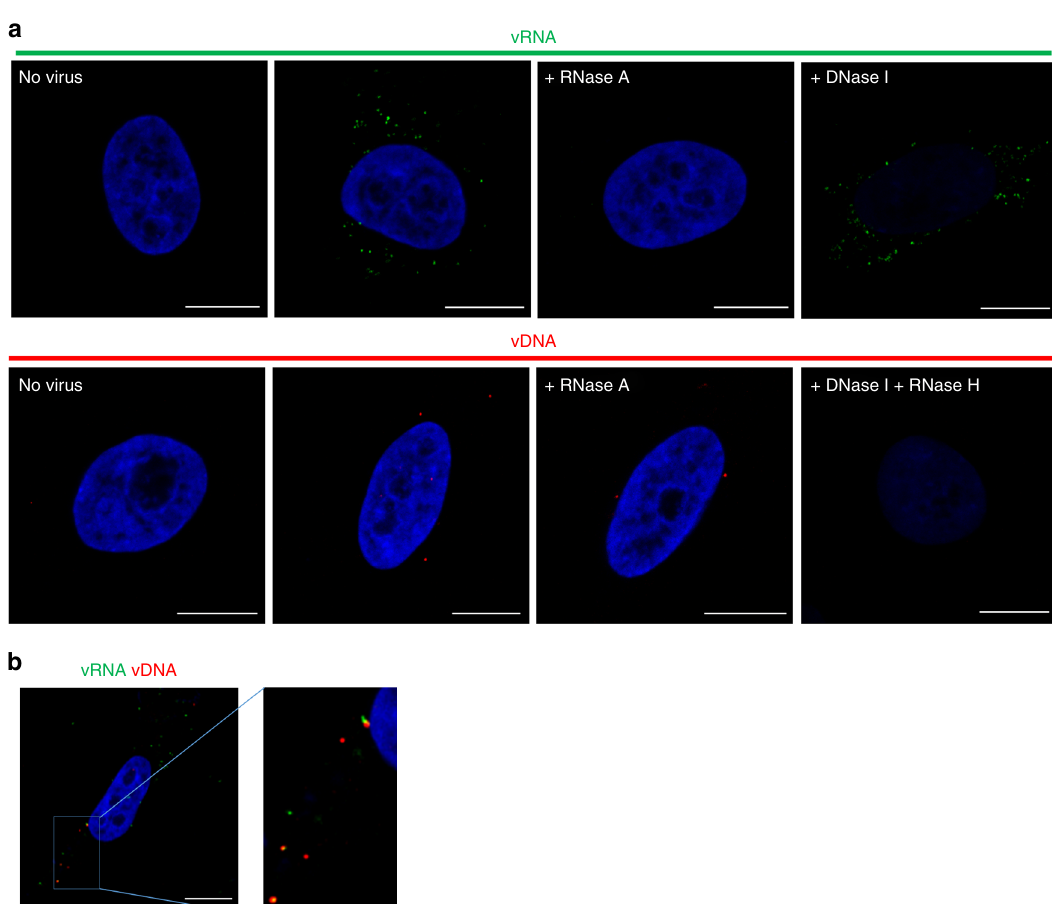
Fig. 1 Visualizing HIV nucleic acids. a vRNA (top panel): TZM-bl cells were infected with HIV-1 at a multiplicity of infection (MOI) of 1; at 5 hpi cells were fi xed and stained. Prior to RNA labeling, cells were treated with buffer alone, RNase A or DNase I. Probe set 1 or PS-1 was used for vRNA (green); nuclei are DAPI stained and shown in blue throughout the fi gure. vDNA (bottom panel): Prior to DNA labeling cells were treated with RNase A or RNase H followed by DNase I. Probe set PS-3 was used for vDNA (red). b Simultaneous detection of vRNA and vDNA of incoming virus in the cytoplasm. TZM-bl cells were infected with HIV-1 at an MOI of 1; at 4 hpi cells were fi xed and stained for vRNA (PS-2; green), vDNA (PS-3; red), and nuclei (blue). Enlarged image shows co-localization between vRNA and vDNA. Scale bars represent 10 µ